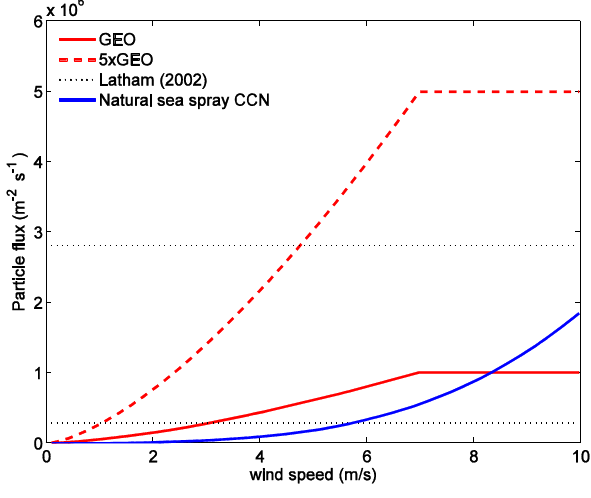
Fig. 1. Wind speed dependence of simulated geoengineering fluxes (red lines) and natural flux of sea spray particles larger than 70nm (blue line). Black dotted lines show the Latham (2002) estimate range for a flux needed to produce 400 additional cloud droplets per cm − 3 .